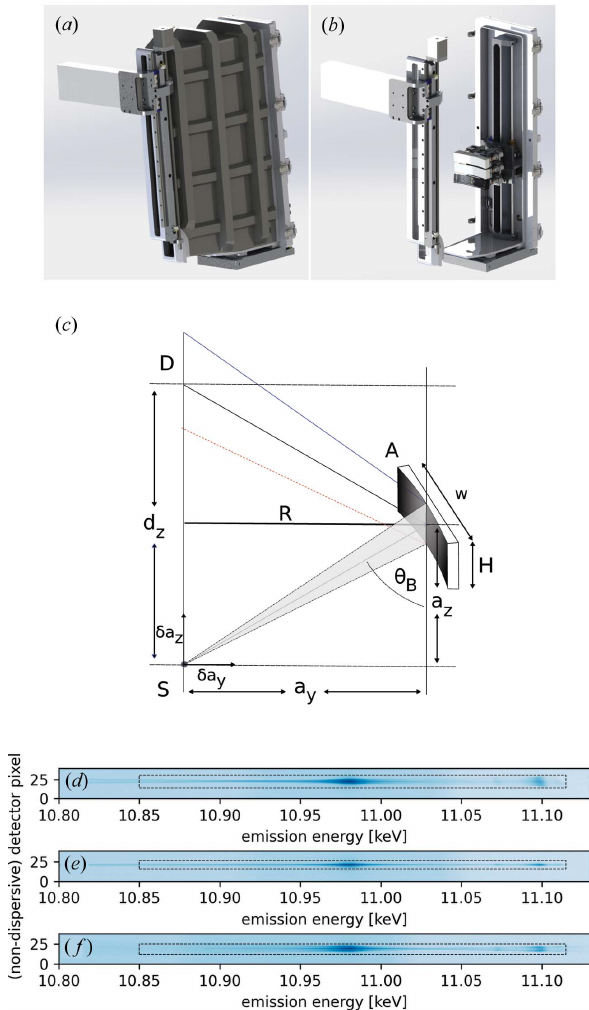
Figure 1 ( a , b ) Three-dimensional renderings of technical drawings of the von Ha´mos spectrometer. ( a ) An orthographic view of the entire chamber including the used Maxipix pixel detector. ( b ) Same as ( a ) but with a transparent vacuum chamber. ( c ) A schematic drawing of the von Ha´mos geometry; for clarity only the central analyzer crystal is shown (S: source/ sample; R : crystal-analyzer bending radius; D: detector; d z : detector position; A: analyzer; a z : vertical analyzer position; a y : horizontal analyzer position; (cid:2) : Bragg angle; H : analyzer height; w : analyzer width; B (cid:2) a z : vertical deviation from the ideal sample position; (cid:2) a y : horizontal deviation from the ideal sample position). ( d )–( f ) Sections of typical detector images showing the footprints of non-resonant XES from a germanium single-crystal sample. Possible regions of interest are indicated with thin dashed black lines. Images are shown on a logarithmic intensity